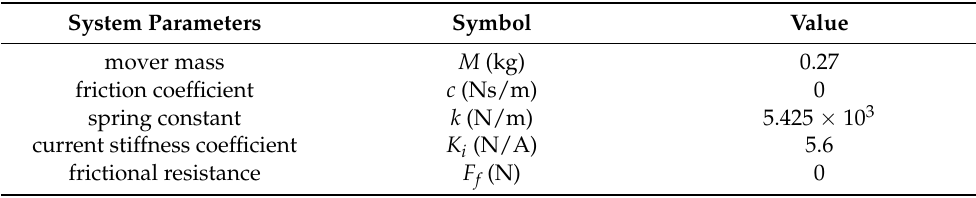
Table 1. Dynamic model parameters.